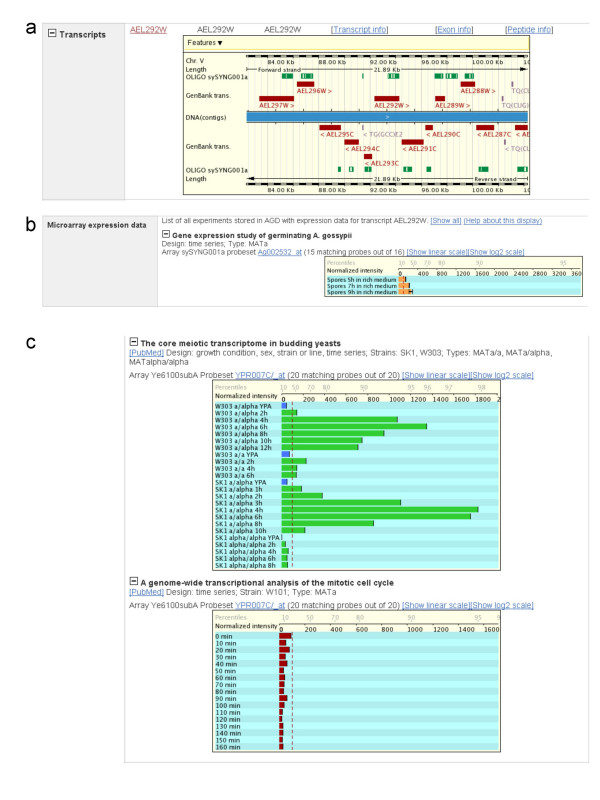
Microarray expression data for A. gossypii and S. cerevisiae. Panel a gives an overview of the genomic localization of genes. The target sequences recognized by microarray oligonucleotide probes present on the Ashbya GeneChip (SYNG001a) are indicated in green. Panels b and c show a bar diagram of normalized array expression signals obtained with germinating Ashbya spores and hyphae growing on rich medium compared to data obtained for the budding yeast orthologs expressed on various growth and sporulation media as indicated.